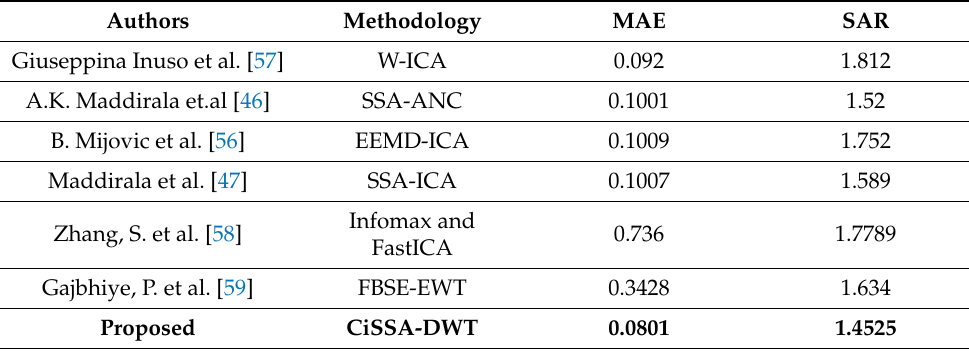
Table 6. Comparison of proposed method MAE and SAR values with existing